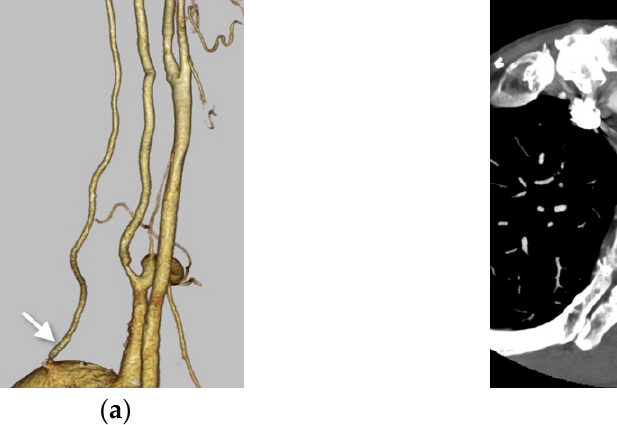
Figure 3. Right VA originating from the aortic arch. ( a ) Right anterior oblique view on volume- rendered computed tomography (VR-CT) angiography shows the RVA directly arising from the aortic arch distal to the left subclavian artery (white arrow). ( b ) Axial contrast-enhanced CT shows the right vertebral artery (white arrow) arising from the aortic arch as the fourth branch. The Ziostation 2 (Ziosoft Inc., Tokyo, Japan) was used to obtain the VR image.